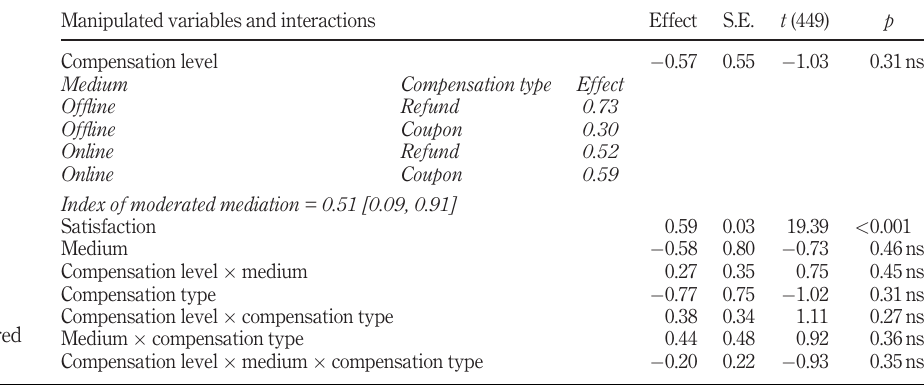
Manipulated variables and interactions